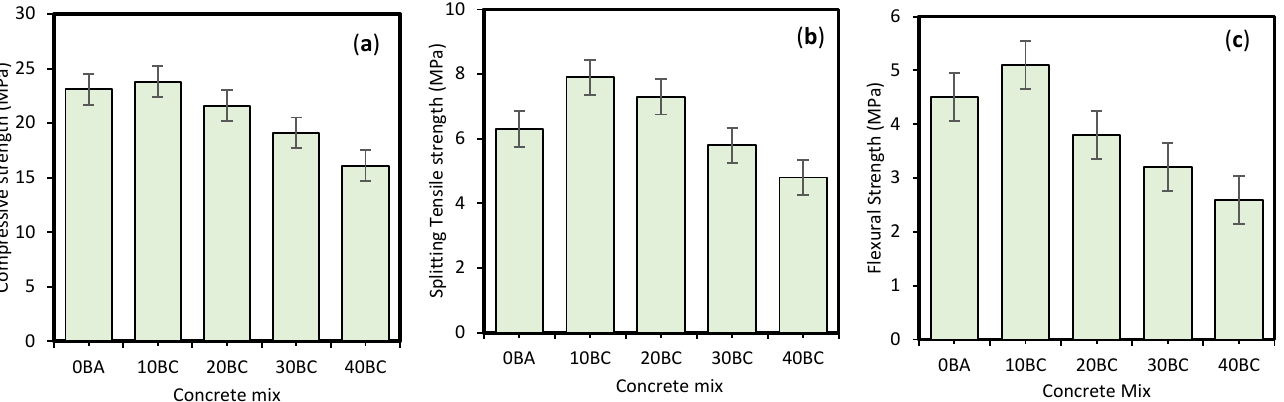
Figure 2. Experimentally tested results of ( a ) compressive strength, ( b ) tensile strength, ( c ) flexural strength of bagasse ash concrete (BAC).